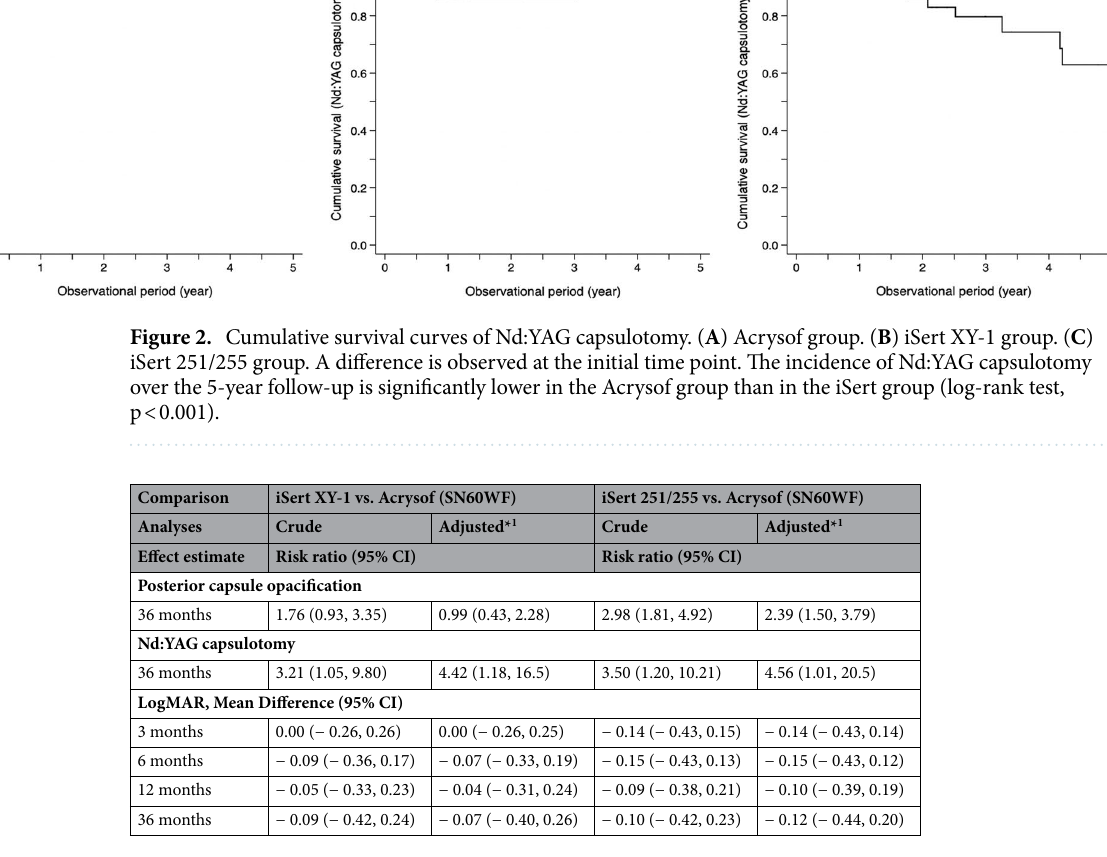
Table 2. Cumulative incidence ratio (risk ratio) for posterior capsule opacification and Nd:YAG capsulotomy, and mean differences in logMAR levels over 36-month follow-up between the Acrysof (SN60WF, reference) and iSert groups (XY-1 or 251/255, index). For the adjusted model, age, sex, diabetes mellitus, and sarcoidosis were included as covariates (*1). SD standard deviation, CI confidence interval, LogMAR log of the minimum angle of resolution.